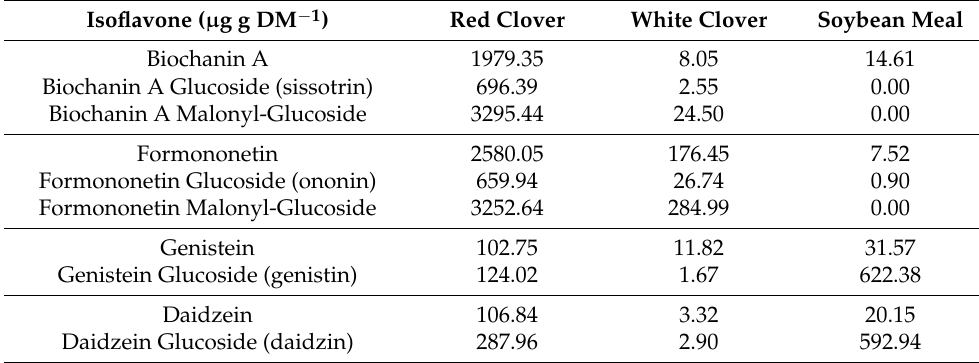
Table 2. Isoflavone concentrations in red clover, white clover, and soybean